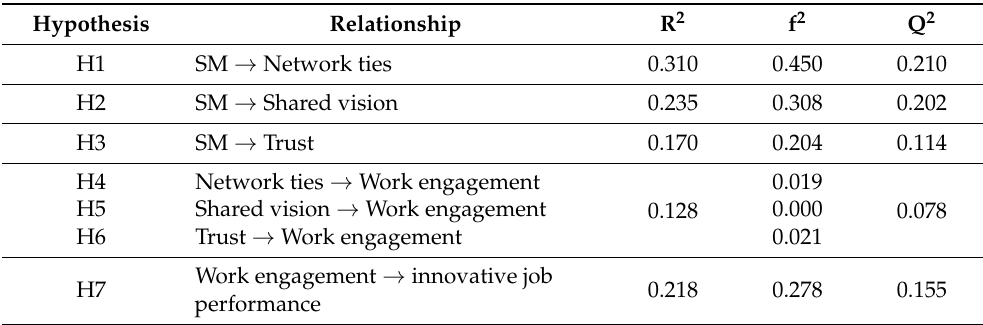
Table 6. The result of the coefficient determination (R Square), Effect Size (f Square), and predictive relevance (Q